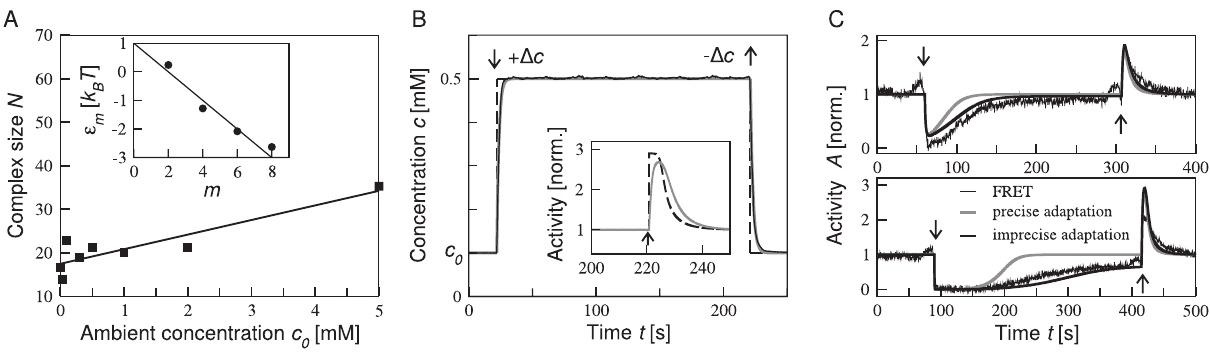
Figure 2. Model ingredients. (A) Size of adapted receptor complex N (total number of Tar and Tsr receptors per complex) as function of ambient concentration c 0 (corresponding to adapted methylation level m ). Individual complex sizes (symbols) were obtained by fitting MWC model to dose- response curves for addition of MeAsp. These values were fitted by a linear function (line). (A Inset ) Energy contribution to receptor complex free energy from methylation level m per receptor dimer. Shown are fitting parameters for Tar receptors from [41] (symbols), as well as linear fit e m ð Þ ~ 1 { 0 : 5 m (in units of k B T with k B the Boltzmann constant and T absolute temperature). (B) Profile of concentration step change as measured experimentally using fluorescent marker (solid black line) [23], exponential fit used in dynamic MWC model for WT1 MeAsp profile (gray line; rate constants l add ~ 0 : 6 = s and l rem ~ 0 : 5 = s ), and perfect step change (black dashed line). Addition and removal times are marked by arrows. (B Inset ) Response of mixed receptor complex to MeAsp removal for perfect (black dashed line) and exponentially fitted step change (gray line). (C) Typical time courses of receptor complex activity in response to two different MeAsp concentration step changes, D c ~ 0 : 05mM (top) and D c ~ 0 : 4mM (bottom), at ambient concentration c 0 ~ 0 : 1mM . Experimental FRET measurement (thin black line), as well as dynamic MWC model for precise (gray lines) and imprecise adaptation (black lines; m max ~ 4 : 1 and K ~ 0 : 5 ). FRET and receptor complex activities were normalized by adapted pre-stimulus values before addition of MeAsp.